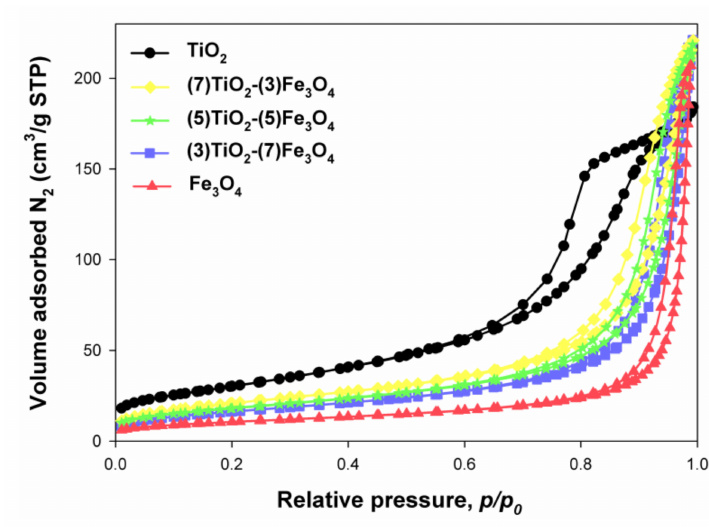
Figure 7. N 2 adsorption / desorption isotherms of TiO 2 -Fe 3 O 4 composites and reference